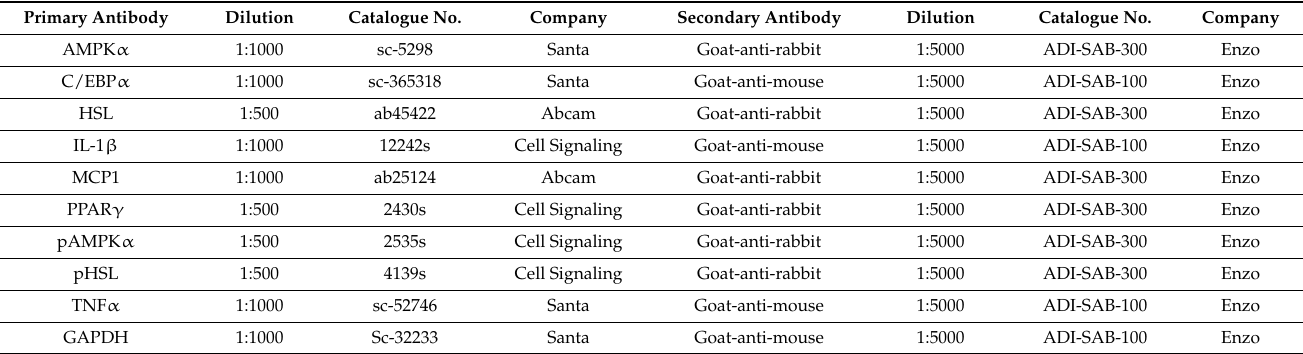
Table 1. Primary and secondary antibodies used for Western